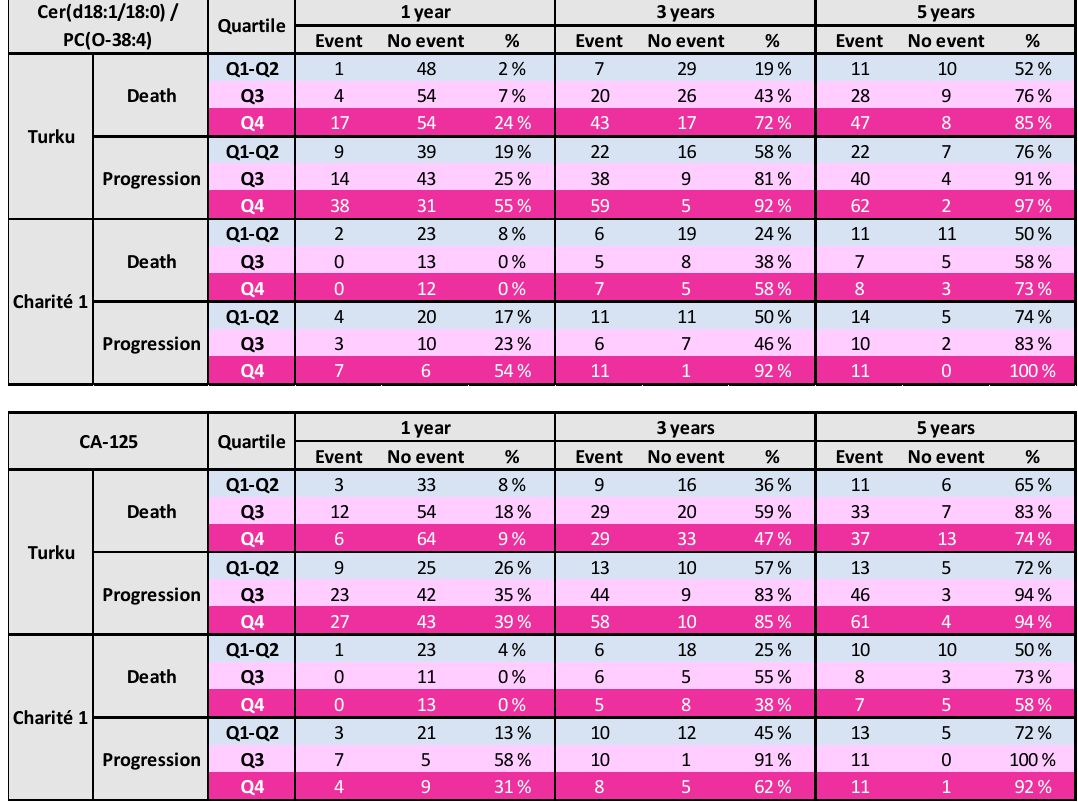
Figure 1. Survival in different quartiles (Q1–Q4) of the lipid ratio (upper panel) or CA-125 (lower panel). Based on the Turku cohort data, a Cox regression model incorporating lipid ratio quartiles and the clinically important risk factors, i.e., FIGO stage and residual tumor after surgery, was constructed to predict the risk of progression after one year and the risk of death within five years of the diagnosis and biomarker measurements. As expected, for stage I–II tumors the risk was generally much lower than for stage III–IV tumors (Figure 2). However, for this population, after five years the risk of death was almost three-fold higher in the highest quartile of the lipid signature when compared to the lowest quartiles. Importantly, the stage III–IV R0 resected patients belonging to the highest biomarker quartile had a higher risk for both worse progression-free and overall survival than patients with a suboptimal surgery result but belonging to the low biomarker quartiles (Figure 2). When only HGSOC patients were included, the results were similar except for stage I–II patients that had higher overall risk (Figure S2).